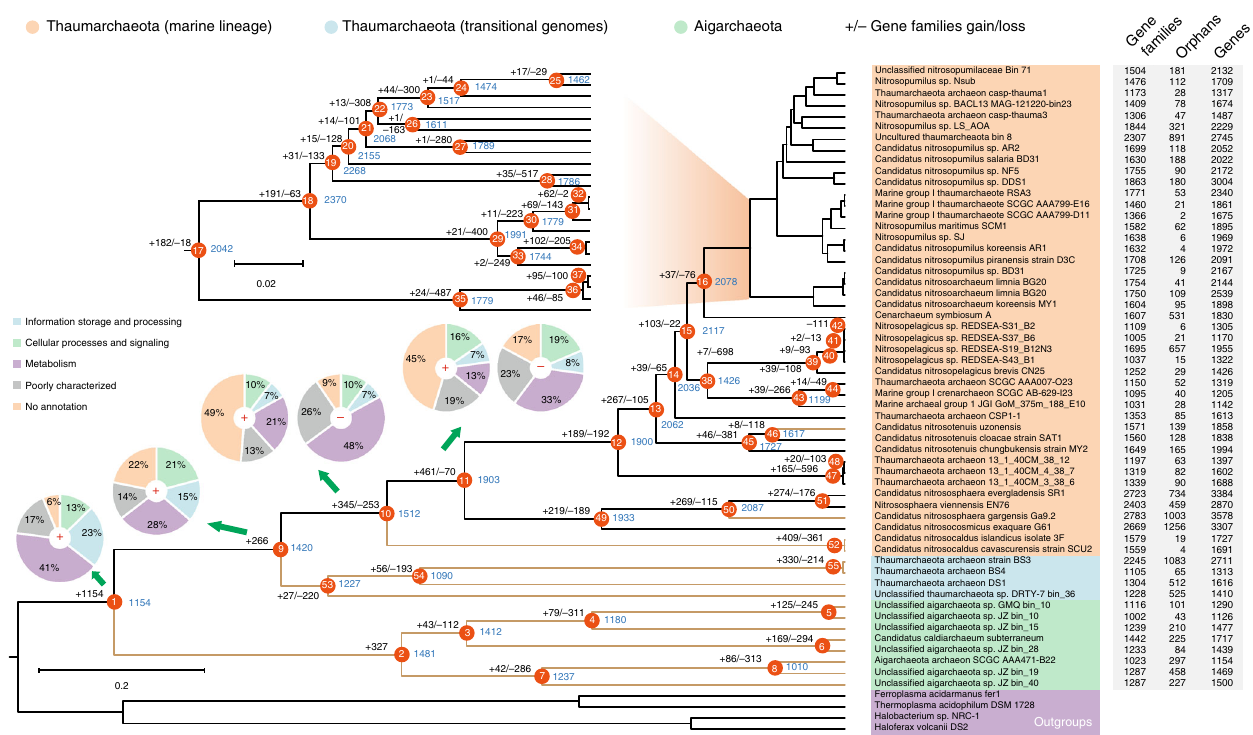
Fig. 3 Ancestral genome content reconstruction using COUNT software. The tree topology is based on the Bayesian tree generated from MrBayes 78 . The numbers of gain and loss events were marked at each lineage of the tree. “ + ” s represent gain events and “ − ” s represent loss events. The red star represents the major gene gain event. The pie chart shows the numbers of gained genes by COG categories. Thermophiles are colored as brown branches in the tree. A list of gained and lost genes for the fours key nodes were shown in Supplementary Data